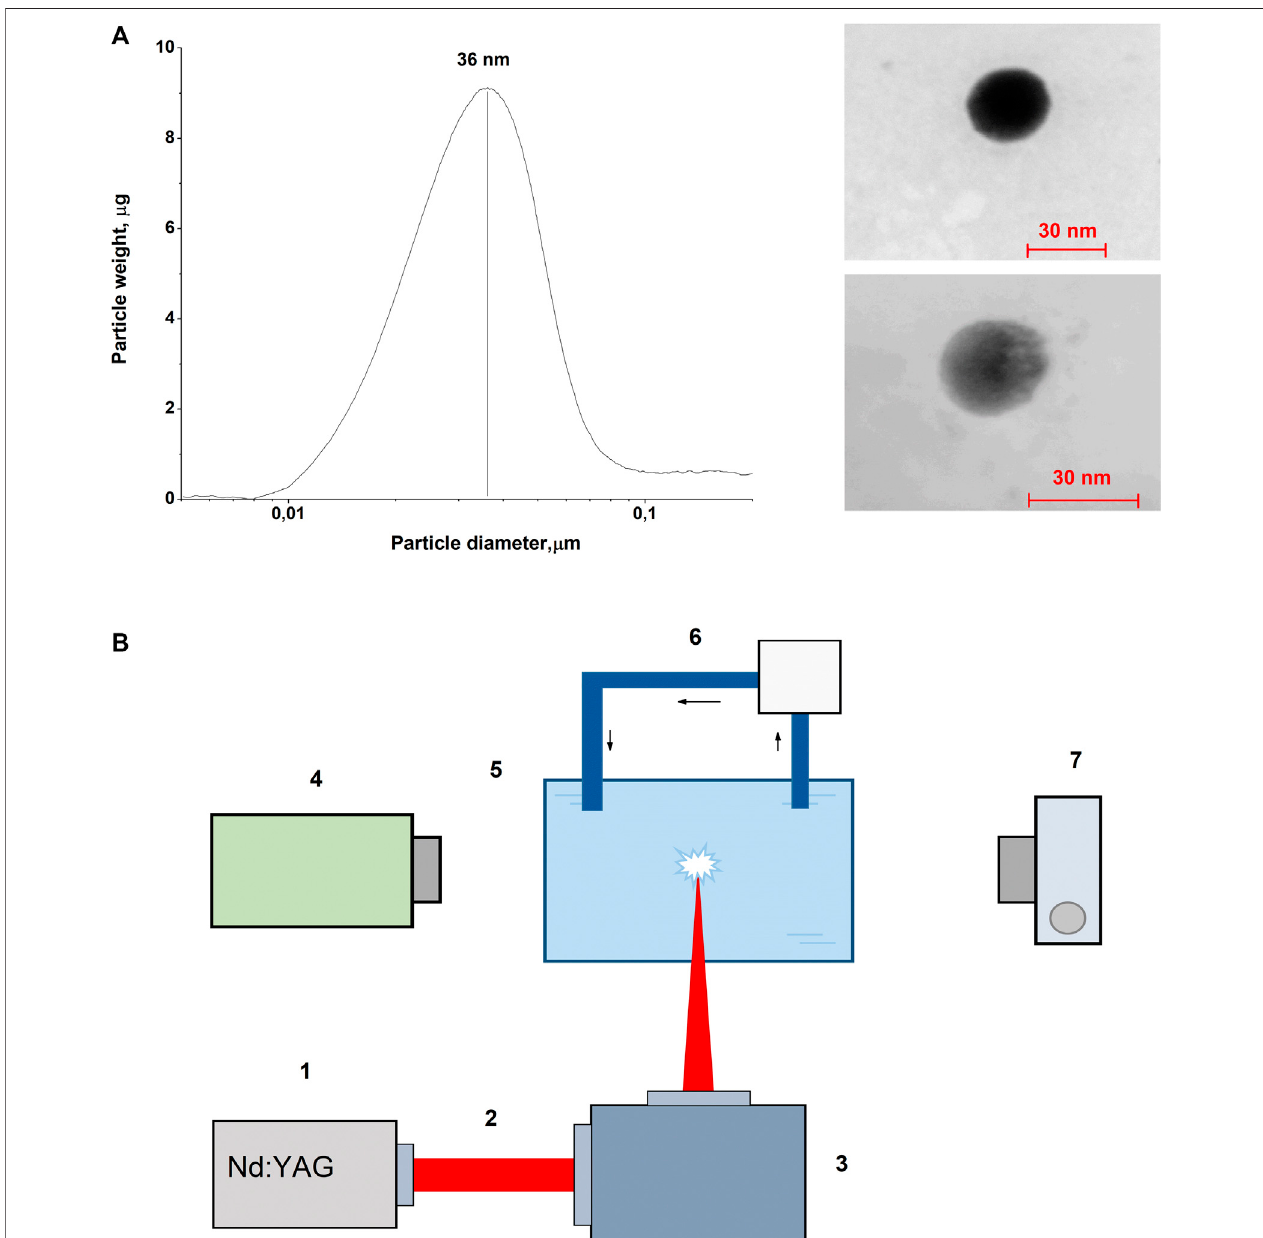
FIGURE 1 | (A) - weight distribution of Fe nanoparticles by size (left) and TEM — images of Fe nanoparticles (right) . (B) - Diagram of the experimental setup. 1 — Laser radiation source, λ (cid:1) 1,064 nm, τ (cid:1) 10 ns, ν (cid:1) 10 kHz, ε (cid:1) 2 mJ; 2 — Laser radiation; 3 — Galvano-optical system ofmirrors; 4 — strip-camera; 5 — Experimental cuvette with a colloidal solution of Fe nanoparticles (n (cid:1) 10 9 NP/ml); 6 — Peristaltic pump; 7- Digital camera.